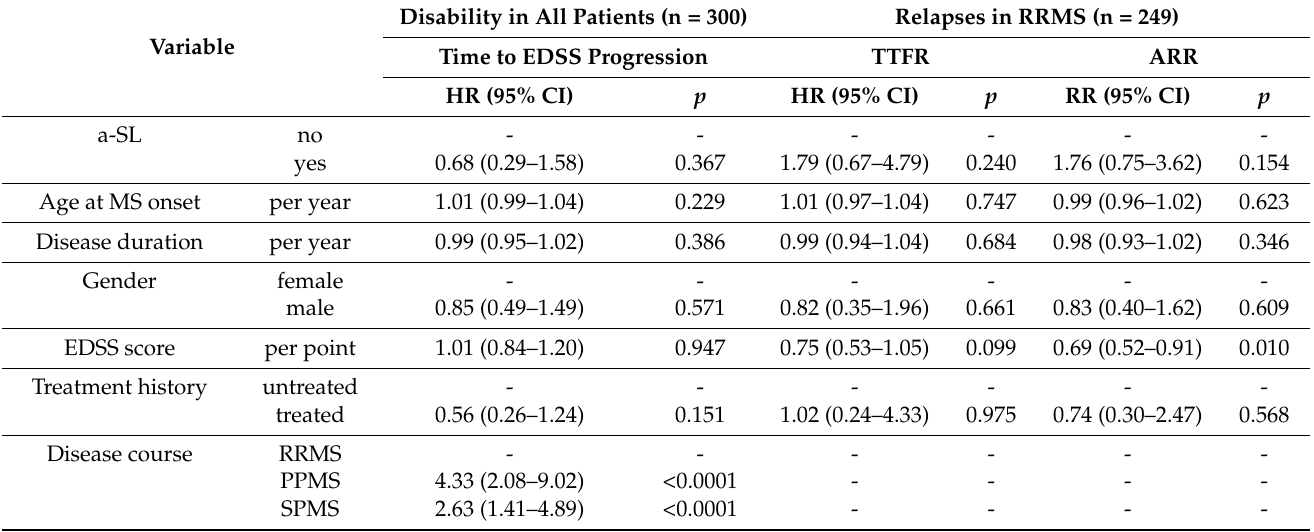
Table 2. Univariate Cox regression and Poisson regression models testing variables associated with time to Expanded Disability Status Scale (EDSS) progression, time to first relapse (TTFR) and annualized relapse rate (ARR).